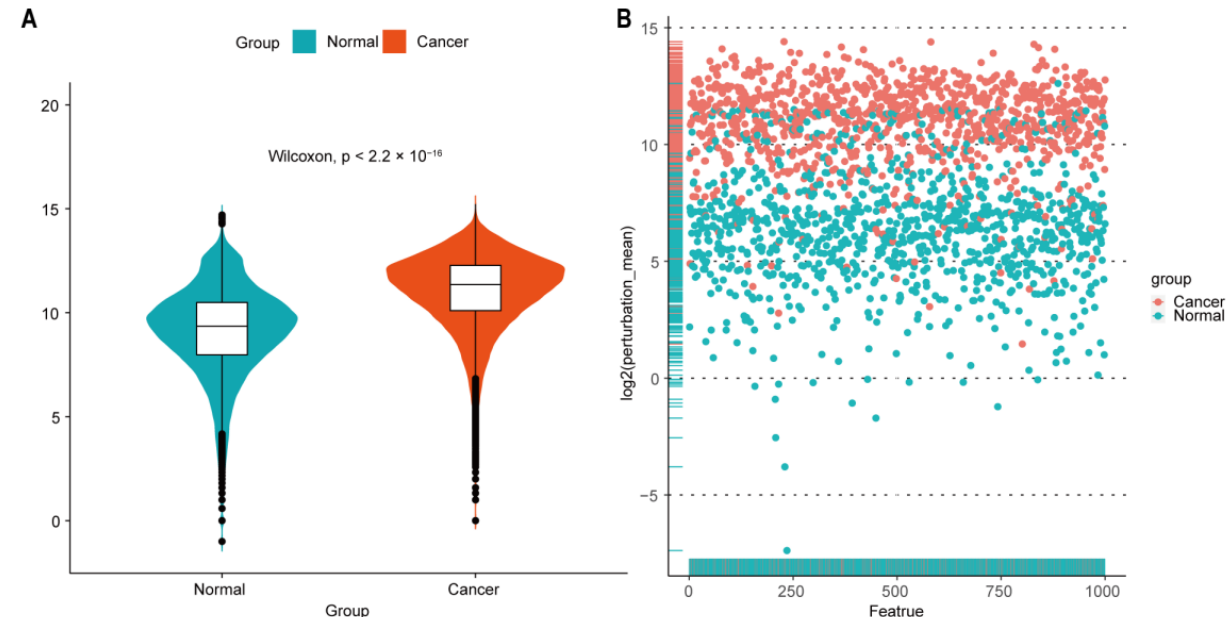
Figure 2. Perturbation of gene interactions in normal and pancreatic cancer tissues. ( A ) Distribution of log2-transformed edge perturbations in both normal and cancer samples. Violin plots show the distributions of the edge perturbations of 1000 randomly selected edges in the edge-perturbation matrix in both the normal and cancer groups. The distributions in these two groups were significantly different, as assessed by the Wilcoxon rank-sum test. ( B ) The scatterplot for the log2-transformed mean of the edge perturbations in the 1000 randomly selected edges in both normal (blue points) and pancreatic cancer (red points) tissues. The edge perturbations of normal samples are much denser and less than those of cancer samples.